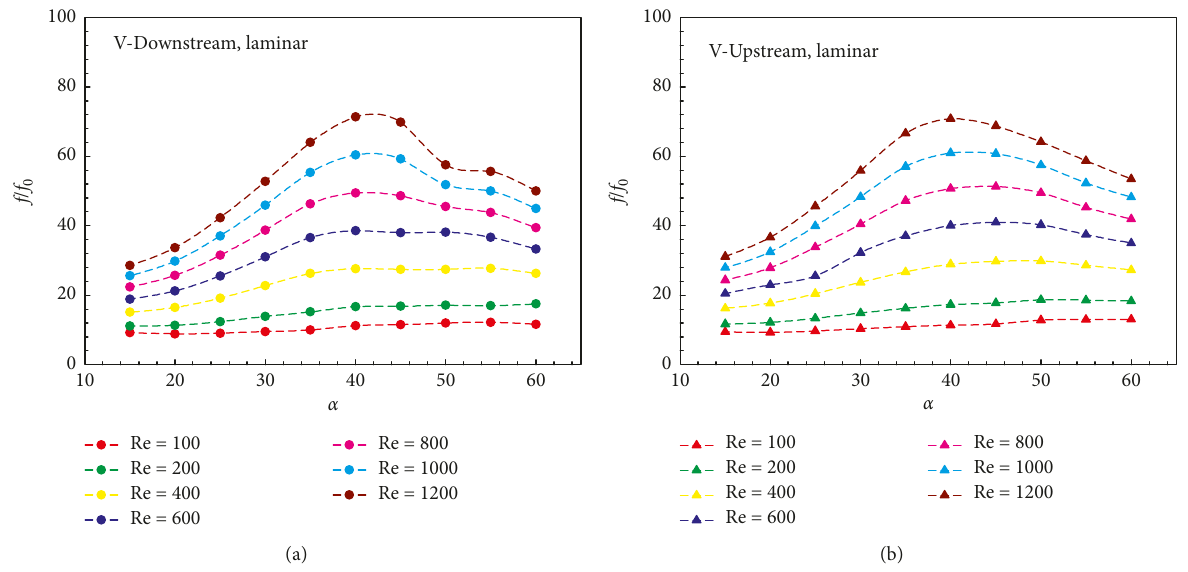
Figure 13: Relations of f / f 0 with α for the heat exchanger tube inserted with the V-wavy surface for (a) V-Downstream and (b) V-Upstream at the laminar regime.